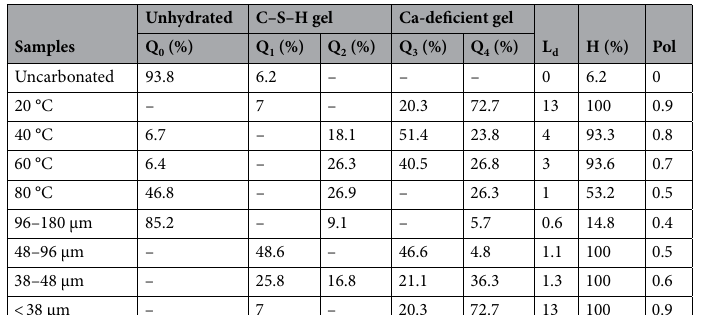
Table 5. Results of 29 Si NMR spectra deconvolution following LFS hydration and carbonation at different reaction temperatures or particle